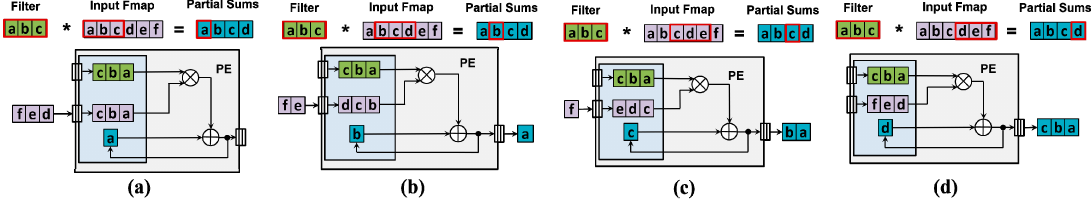
Figure 7. The convolutional computation reuse within a processing element (PE). ( a ) Step 1; ( b ) Step 2; ( c ) Step 3; ( d ) Step 4.